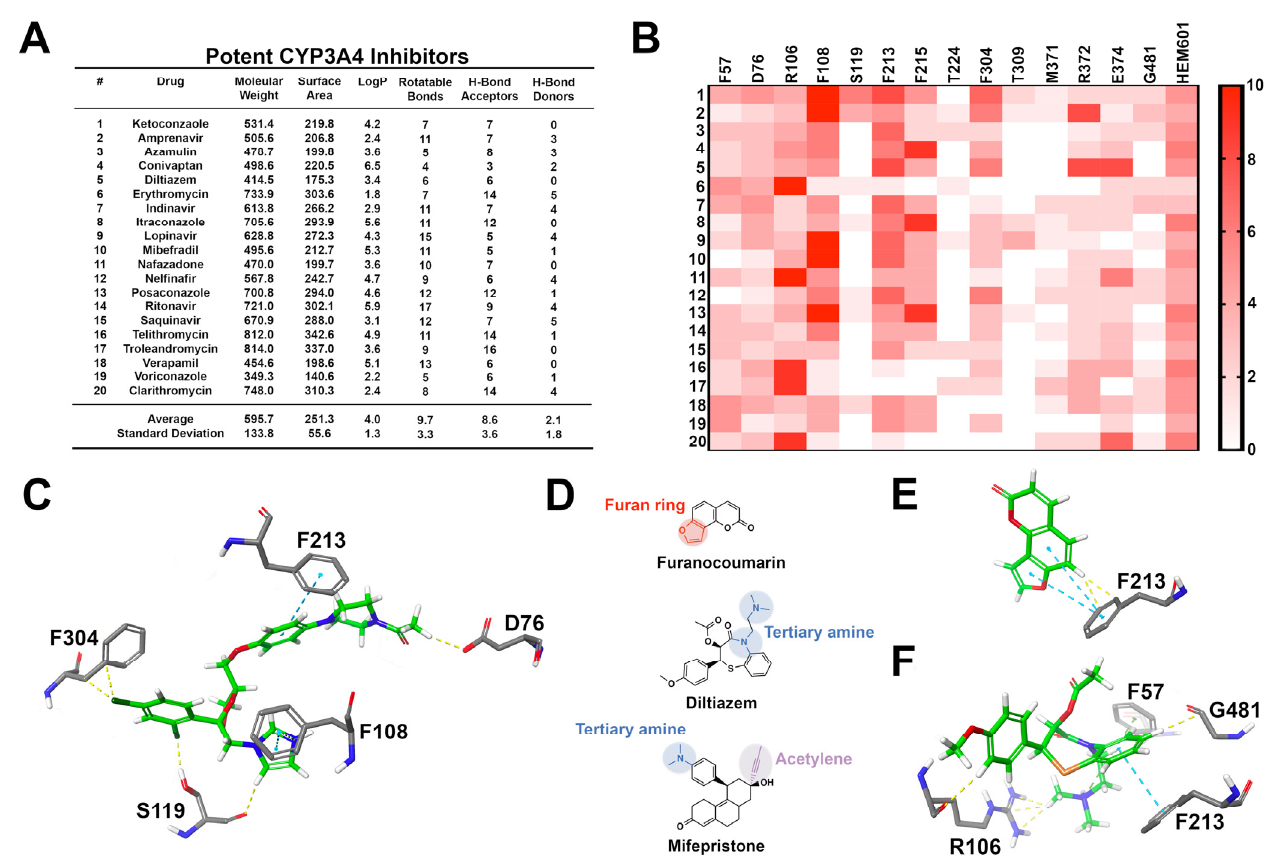
Figure 4. Structural investigation of the 20 most commonly prescribed CYP3A4 inhibitors. ( A ) CYP3A4 inhibitors are large, lipophilic, and flexibility molecules capable of accepting numerous hydrogen bonds. Molecular weight is represented as g/mol or Daltons (Da) and surface area is represented in angstroms (Å). Values were calculated using pkCSM ADMET [38]. ( B ) Heat map representing the frequency of ligand-to-amino acid binding interactions in the top ten most energetically favorable binding poses in docking against CYP3A4 (PDB ID: 1W0E). ( C ) Docking image demonstrating ketoconazole, a potent CYP3A4 inhibitor, making numerous pi–pi stacking interactions (blue dotted lines) with F108, F213, and F304, as well as energetically favorable contacts (yellow dotted lines) with D76 and S119. ( D ) Moieties commonly associated with high-affinity CYP inhibition in the literature, including the presence of a furan ring, tertiary amine, or acetylene group [39]. ( E ) 3D docking image of furanocoumarin, a CYP3A4 inhibitor found in the skin of grapefruit. Furanocoumarin makes several pi–pi stacking interactions and energetically favorable contacts. The furan ring of furanocoumarin specifically lends to pi–pi stacking interactions within the CYP3A4 receptor site. ( F ) 3D docking image of diltiazem, an antihypertensive drug and calcium channel blocker known for inhibiting CYP3A4. Diltiazem forms many pi–pi stacking interactions and energetically favorable contacts.